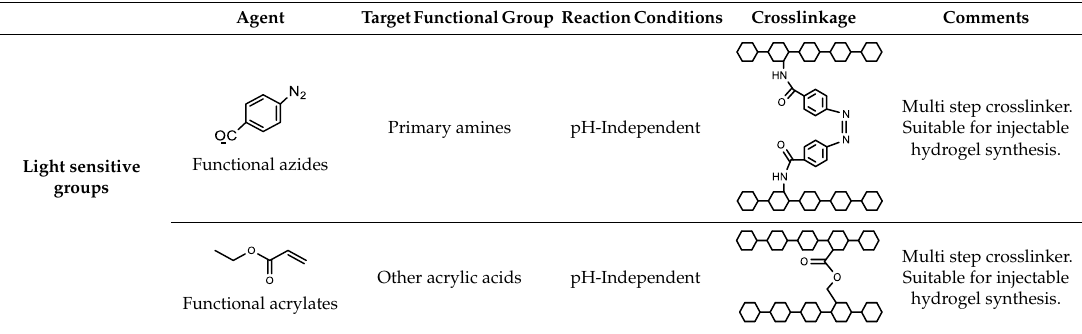
Table 3. Crosslinking of polymers through small molecules and light-sensitive functional groups (Continued).